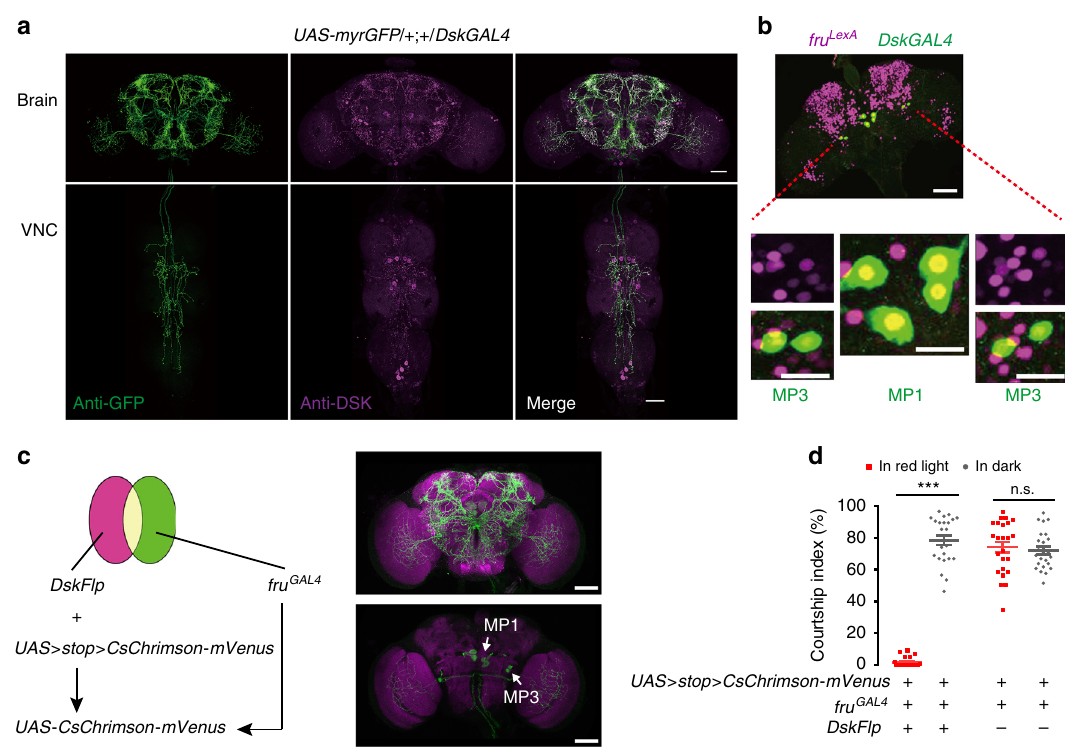
Fig. 2 Four pairs of Dsk - and fru M -expressing neurons inhibit male courtship. a Expression pattern of DskGAL4 in the central nervous system revealed by anti-GFP (left) and anti-DSK (middle). Representative of eight male fl ies. Scale bars, 50 μ m. b Two pairs of MP1 and two pairs of MP3 neurons are co- labeled by fru LexA driving LexAop-RedStinger (magenta) and DskGAL4 driving UAS-Stinger-GFP (green). Representative of fi ve male brains. Scale bars, 50 μ m and 20 μ m (zoom-in). c Intersectional strategy to label and manipulate Dsk and fru M co-expressing MP1 and MP3 neurons. Representative of 6 male brains. Scale bars, 50 μ m. d Optogenetic activation of intersectional neurons between DskFlp and fru GAL4 abolishes male courtship. Red square indicates test in red light, and gray circle indicates test in dark. n = 24 for each. p < 0.001, Kruskal – Wallis test. *** p < 0.001 and p > 0.99 (n.s.), post hoc Dunn ’ s multiple comparisons test. Error bars indicate SEM. Source data are provided as a Source Data fi